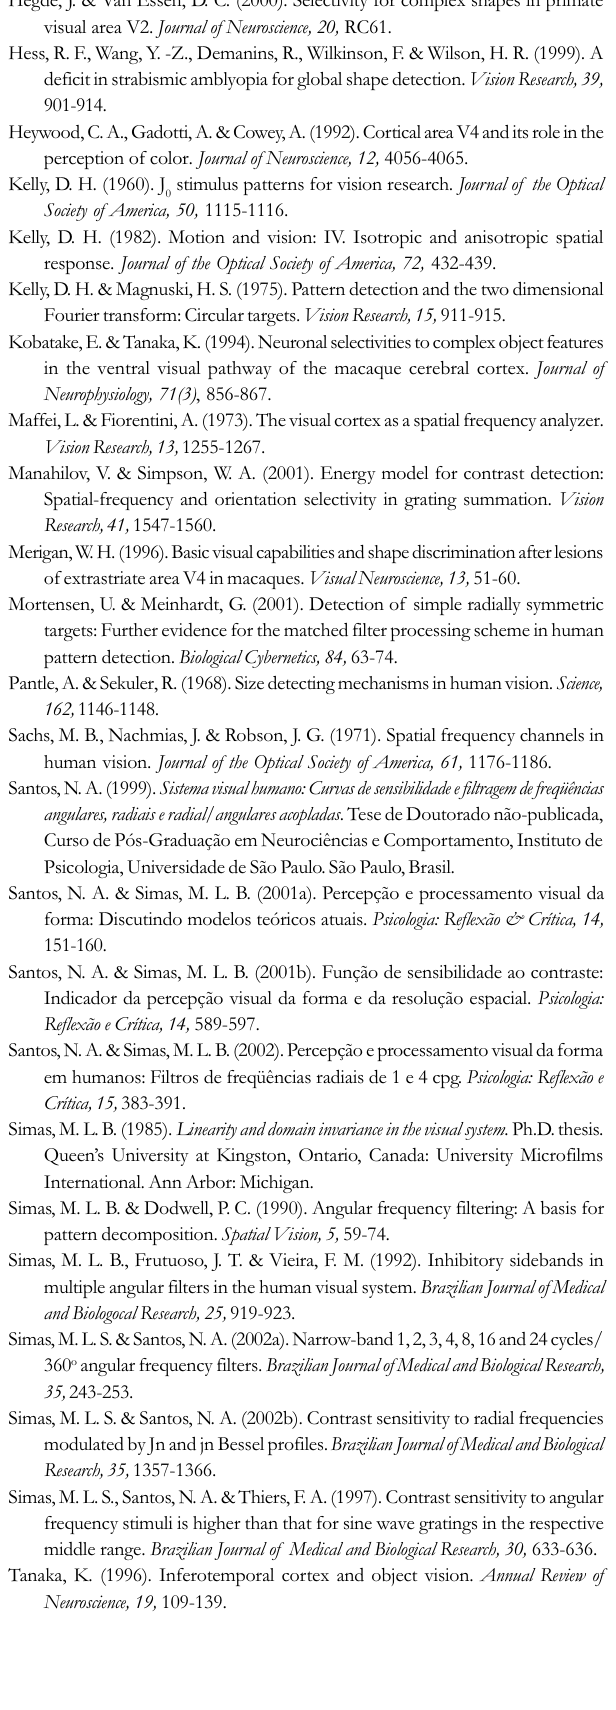
sobre processamento de est(cid:237)mulos elementares em coordenadas polares e o processamento e o reconhecimento de faces